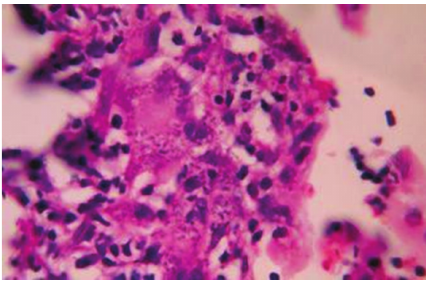
Figure 2: Histological appearance under high